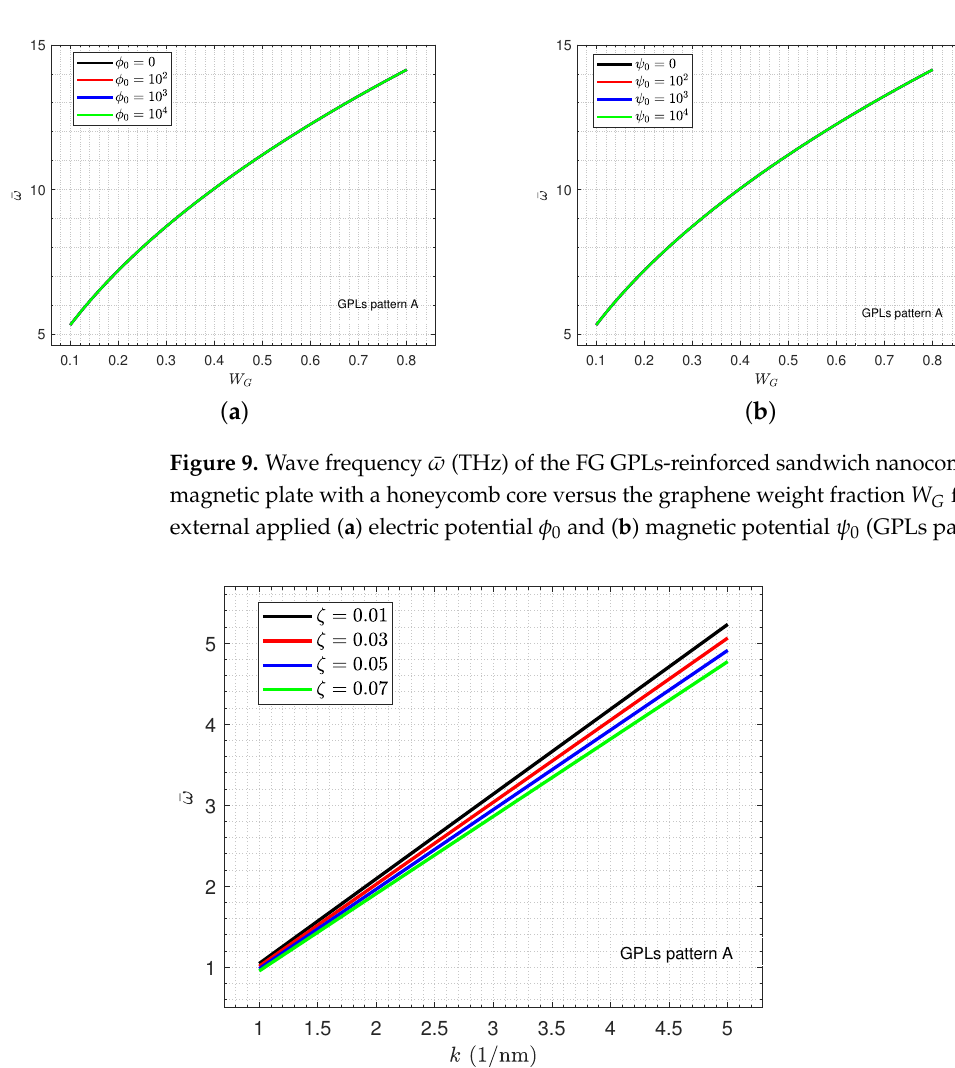
Figure 10. Influences of the thickness-to-length of the cell rib ratio ζ on the wave frequency ¯ ω (THz) of the FG GPLs-reinforced sandwich nanocomposite piezoelectromagnetic plate with a honeycomb core versus the wave number k (GPLs pattern